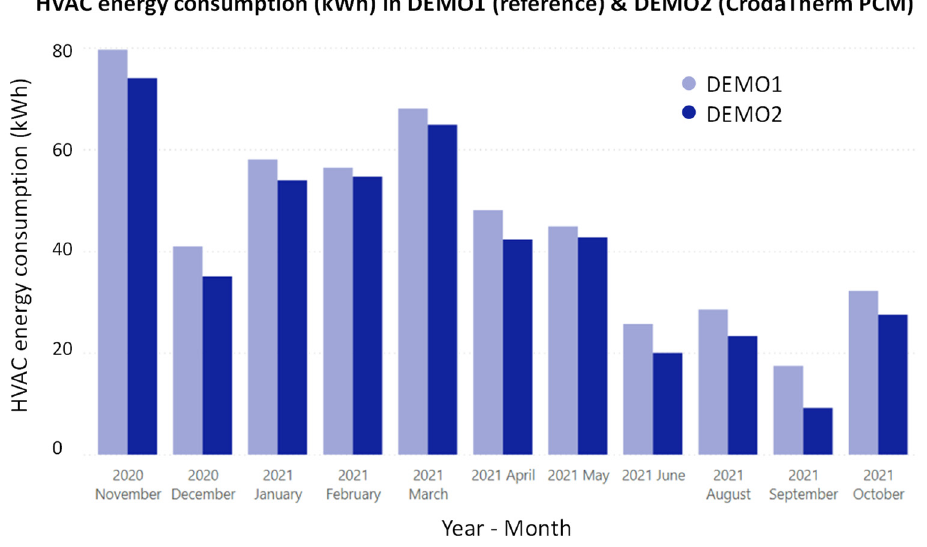
Figure 12. HVAC system energy use during CrodaTherm tests under ‘Conditioned mode’.